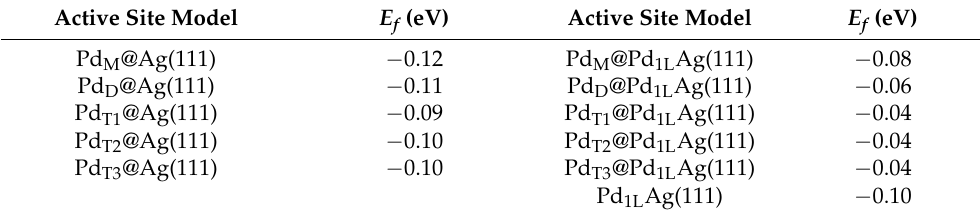
Table 1. The ensemble formation energies, E f , of all structures.